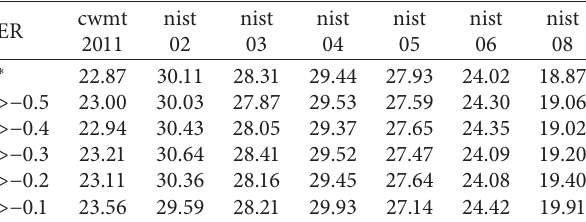
Table 6: BLEU scores based on word alignment filtering (reword alignment).